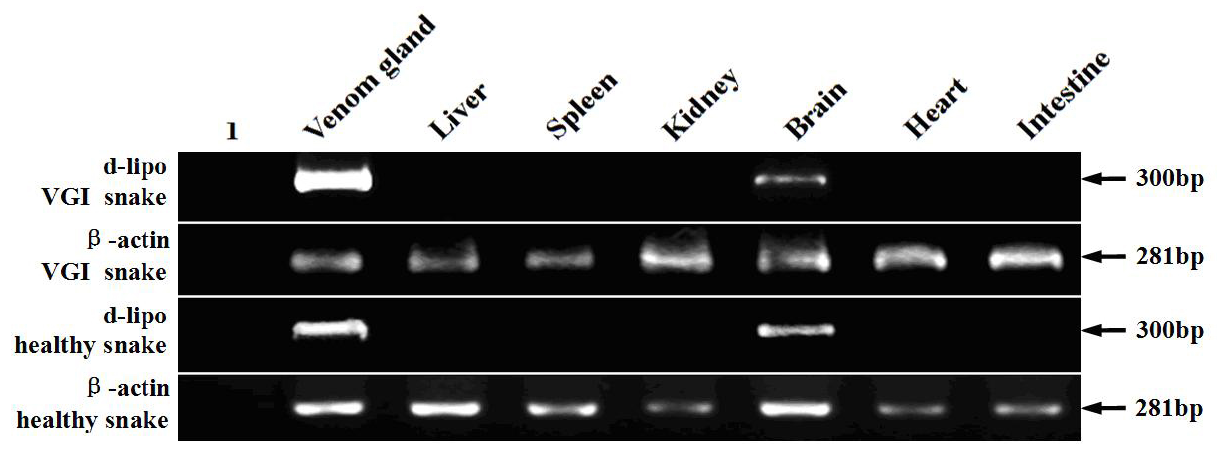
Figure 3. RT-PCR analysis of d-lipo mRNA expression in various tissues of healthy and IVG hundred-pace snakes. ( 1 ) A control reaction without RNA template. β-actin amplification was included as internal control. The size of the products is shown on the